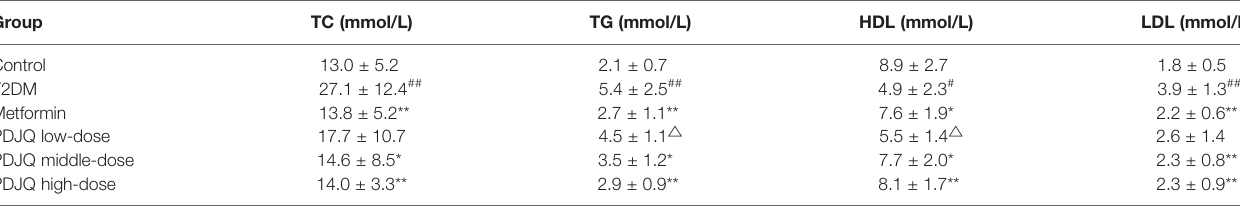
TABLE 1 | Changes in blood lipid levels after PDJQ